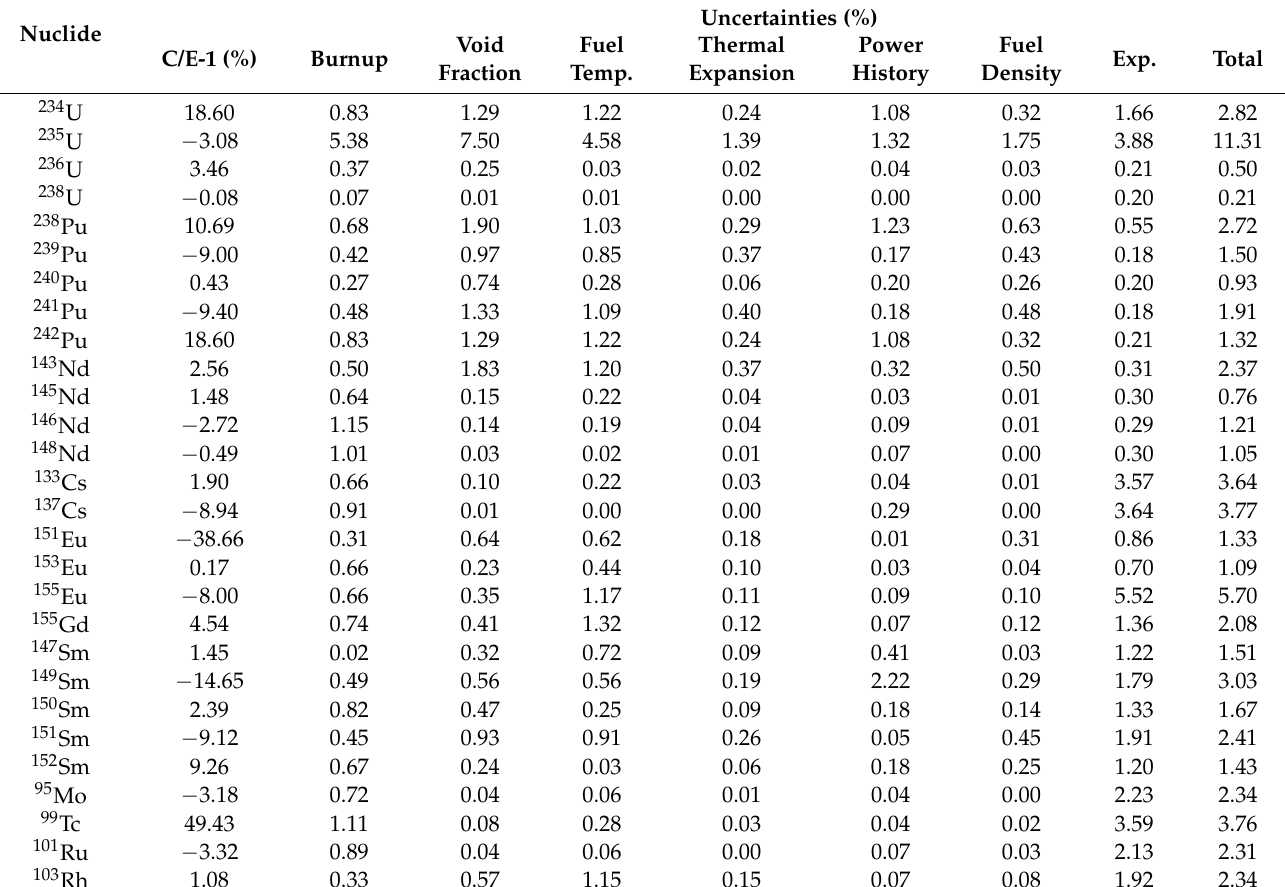
Table 6. C/E-1 (%) and uncertainties for sample 2F1ZN3-A9-UM (68.0